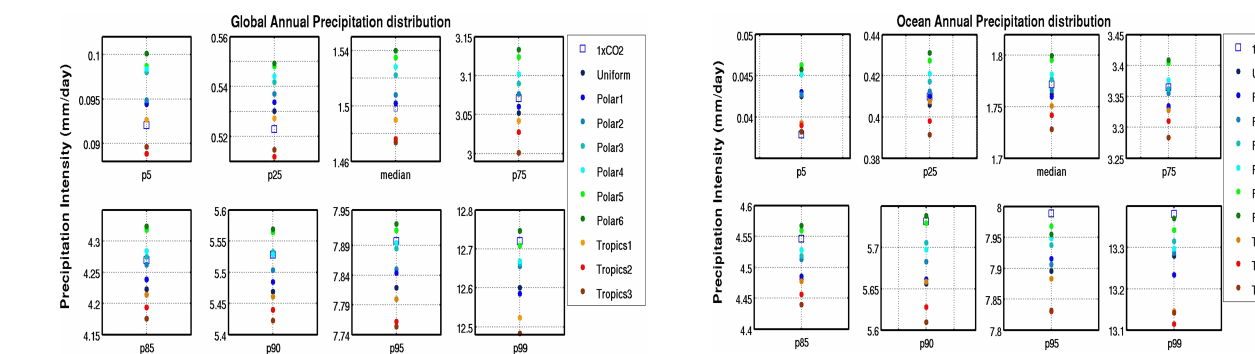
Figure 12. Percentile values (p5, p25, median, p75, p85, p90, p95 and p99) of precipitation intensity over Ocean. There is a monotonic increase in precipitation for all percentile values as the maximum concentration of aerosols over poles increases. Grid-level monthly mean precipitation over all ocean points are used to calculate the percentile values.The last 30 years of 60-year simulations are used for the